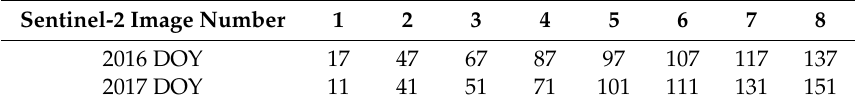
Table 1. Day of Year (DOY) of Sentinel-2 images used for both 2016 and 2017 cropping seasons. Sentinel-2 Image Number